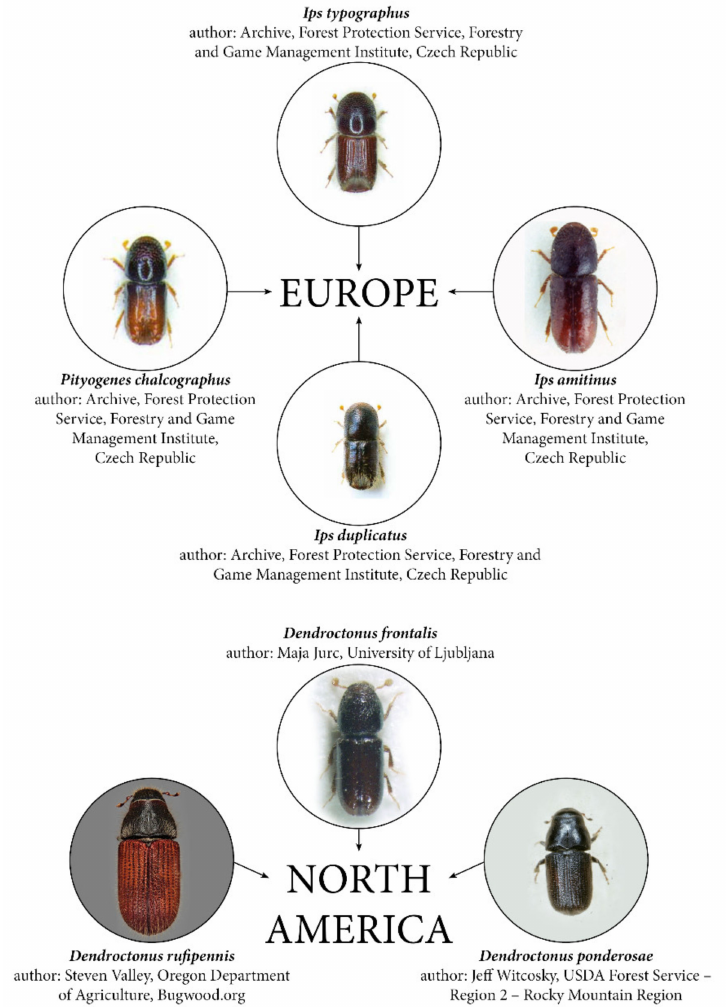
Figure 1. Examples of the most common and widespread bark beetle species that attack coniferous trees in Europe and North